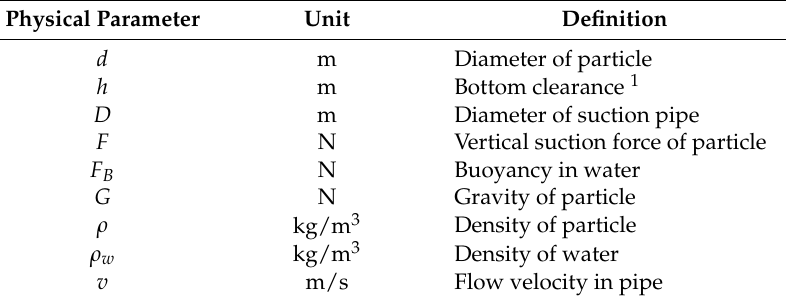
Figure 4. Main parameters of the model. Table 1. Definition of main parameters.